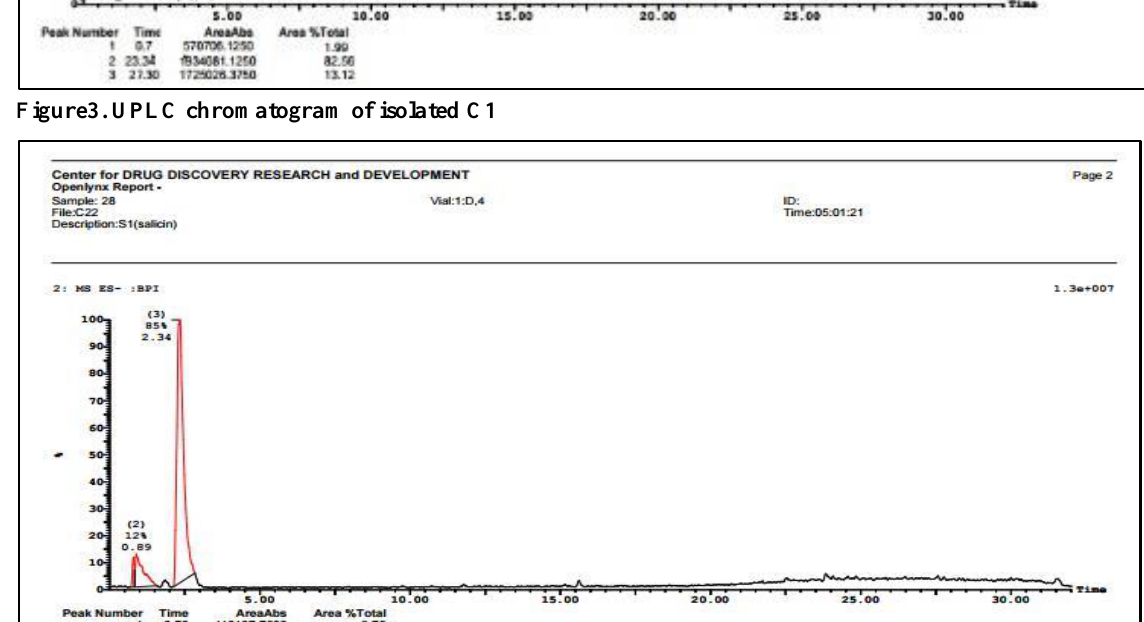
Figure3. UPLC chromatogram of isolated C1